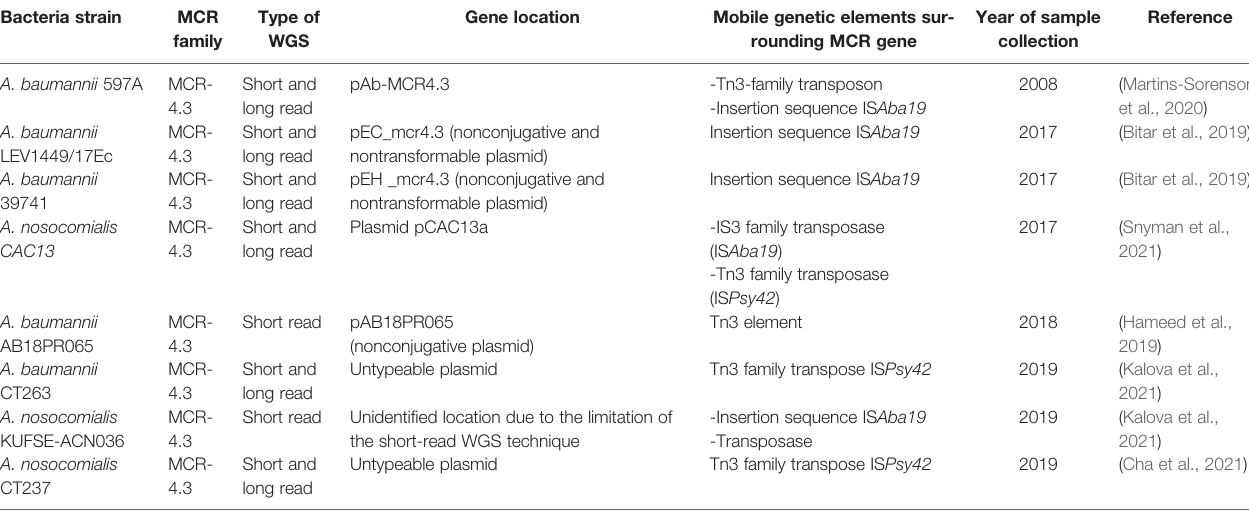
TABLE 4 | Location of the mcr gene in Acinetobacter spp. and surrounding mobile genetic elements. Bacteria